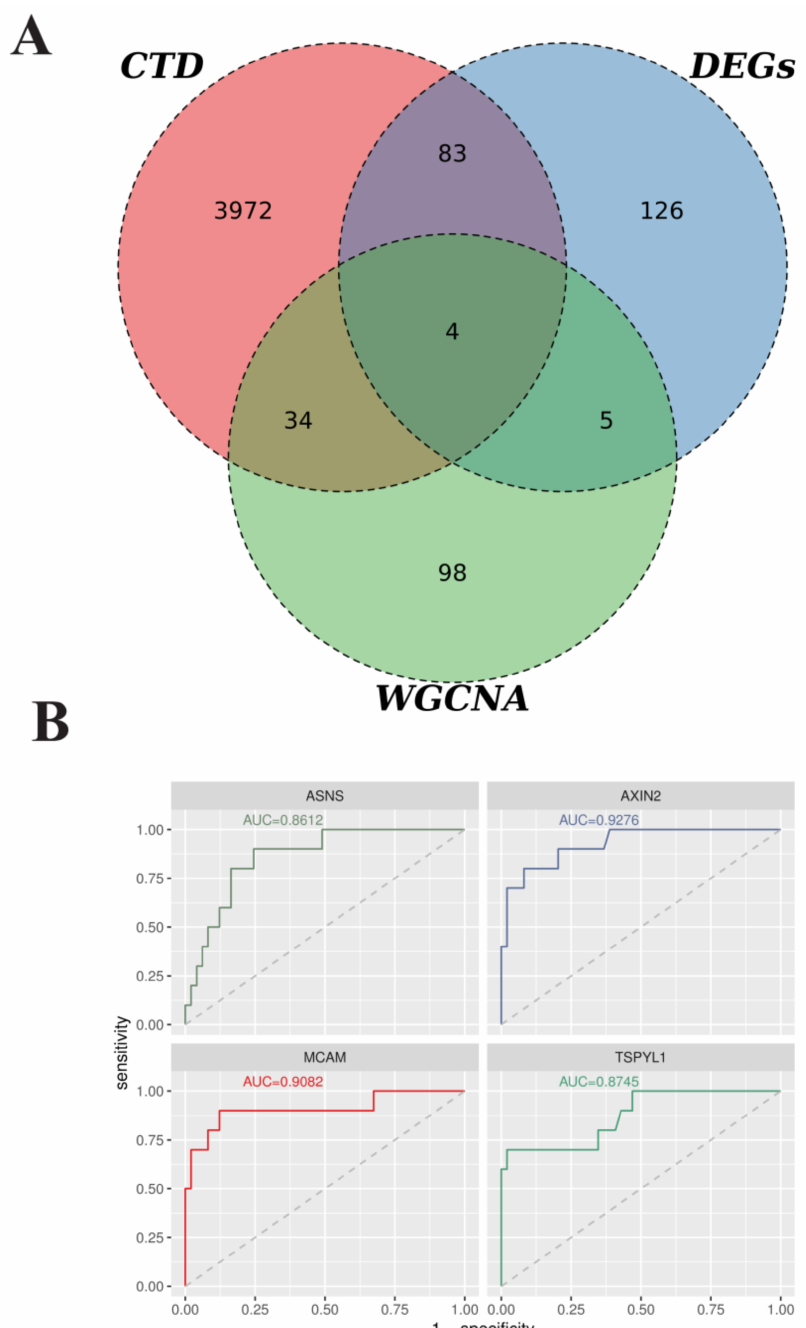
Figure 5. Identification and validation of the AAA-related hub genes. ( A ) Venn plots of intersection genes among the AAA-related 218 DEGs, 144 WGCNA-based hub genes, and 4093 CTD-based genes. ( B ) ROC curves and AUC values of the ASNS, AXIN2, MCAM, and TSPYL1. x-axis indicates specificity; y-axis indicates